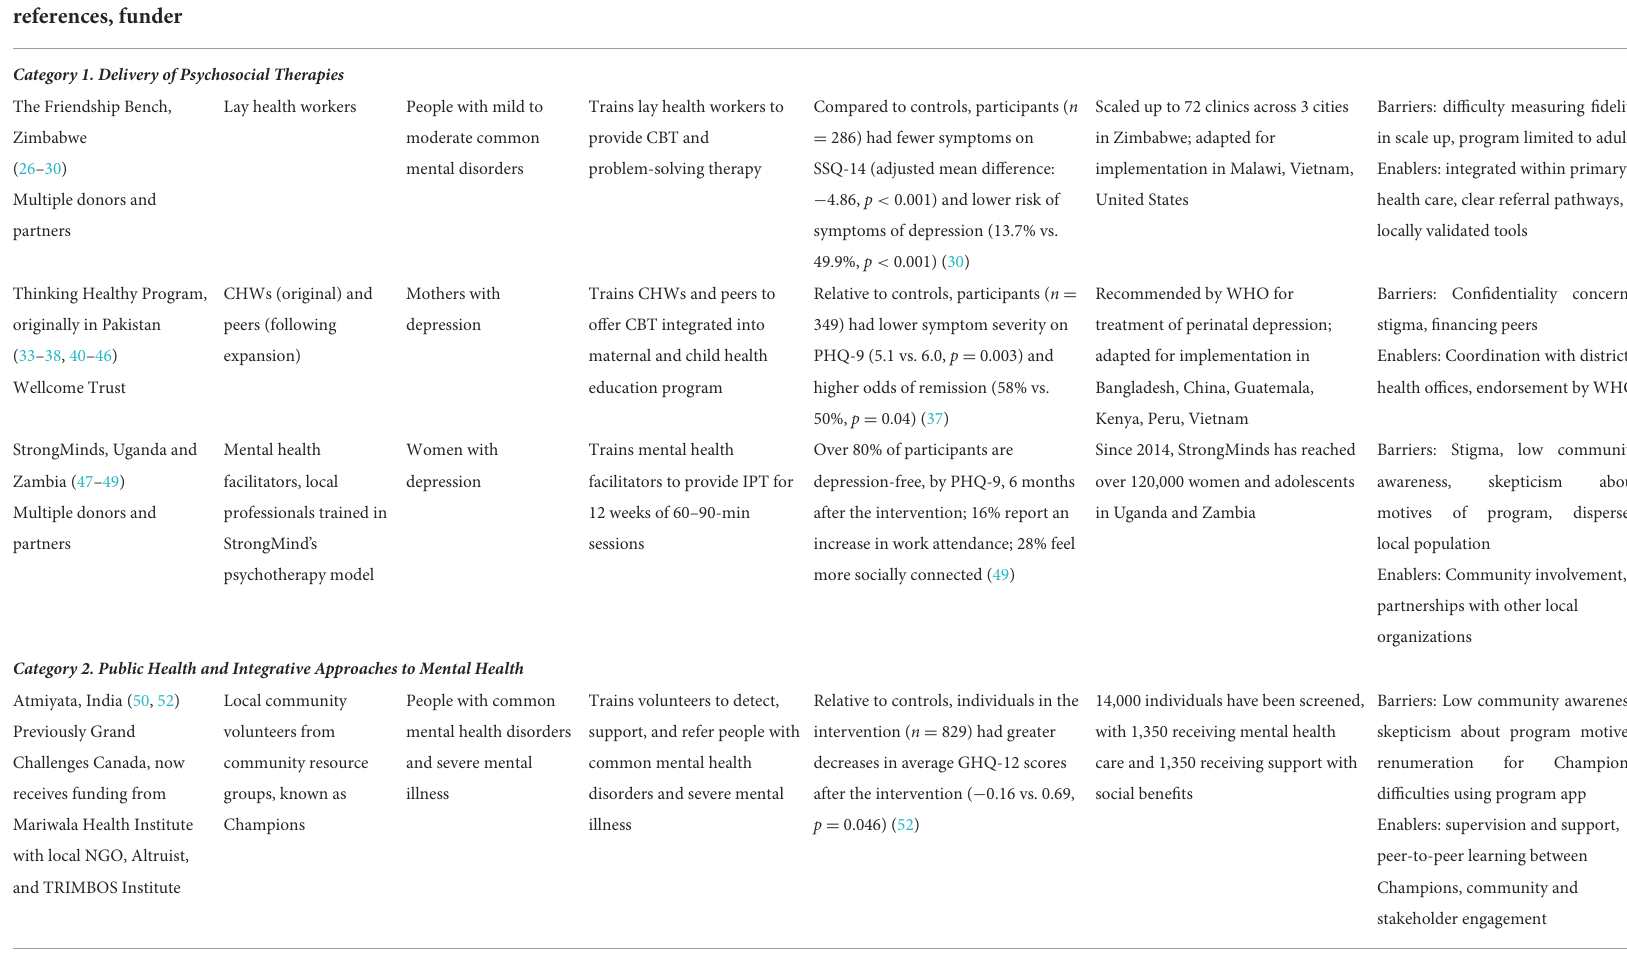
TABLE 1 Summary of selected